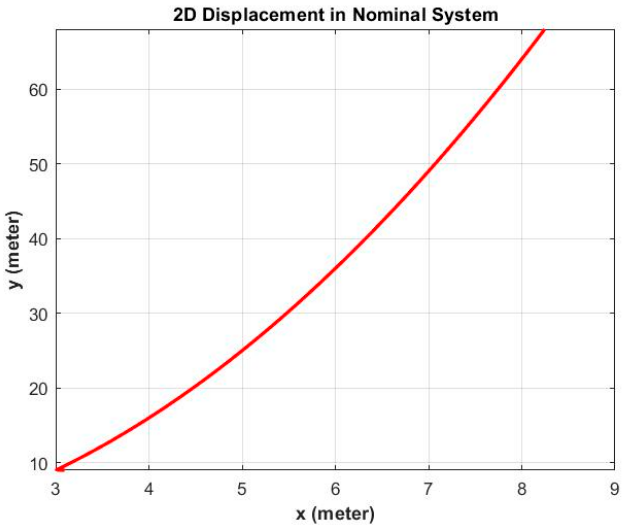
Figure 5. The constrained route of the ship system for the constraint equation ϕ 2 s = x 2 − y = 0.